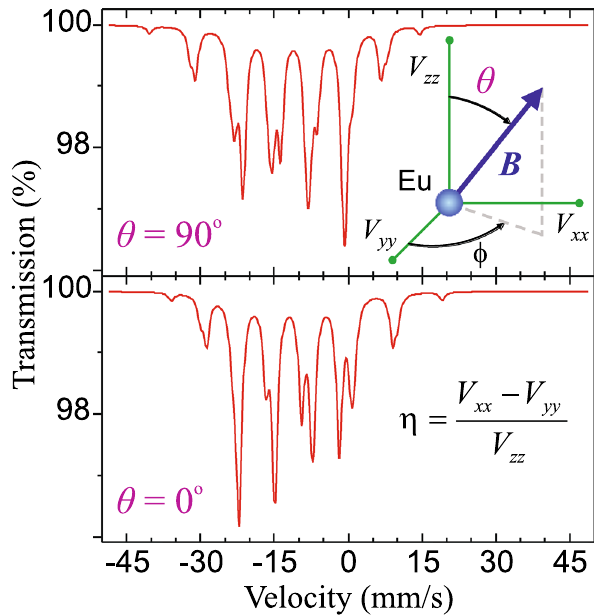
Figure 9. Simulated 151 Eu Mössbauer spectra for two extreme values of the θ angle, i.e. 90° and 0°. The other hyperfine parameters are constant and their values are close to those for EuFe 2 As 2 , i.e. δ = −11.4 mm/s, V zz = −0.49 (10 22 V/m 2 ), and B = 26.6 T. The spectral linewidths are equal to the natural width and the optimal effective absorber thickness was applied. Clearly visible change of the relative intensity of spectral lines illustrates the high sensitivity of 151 Eu Mössbauer spectroscopy to the phenomenon of spin reorientation. On the other hand, the angle is undetectable for the quadrupole asymmetry parameter η = 0, i.e. V xx = V yy , which is a case of tetragonal structure with V zz along c -axis of the unit ϕ